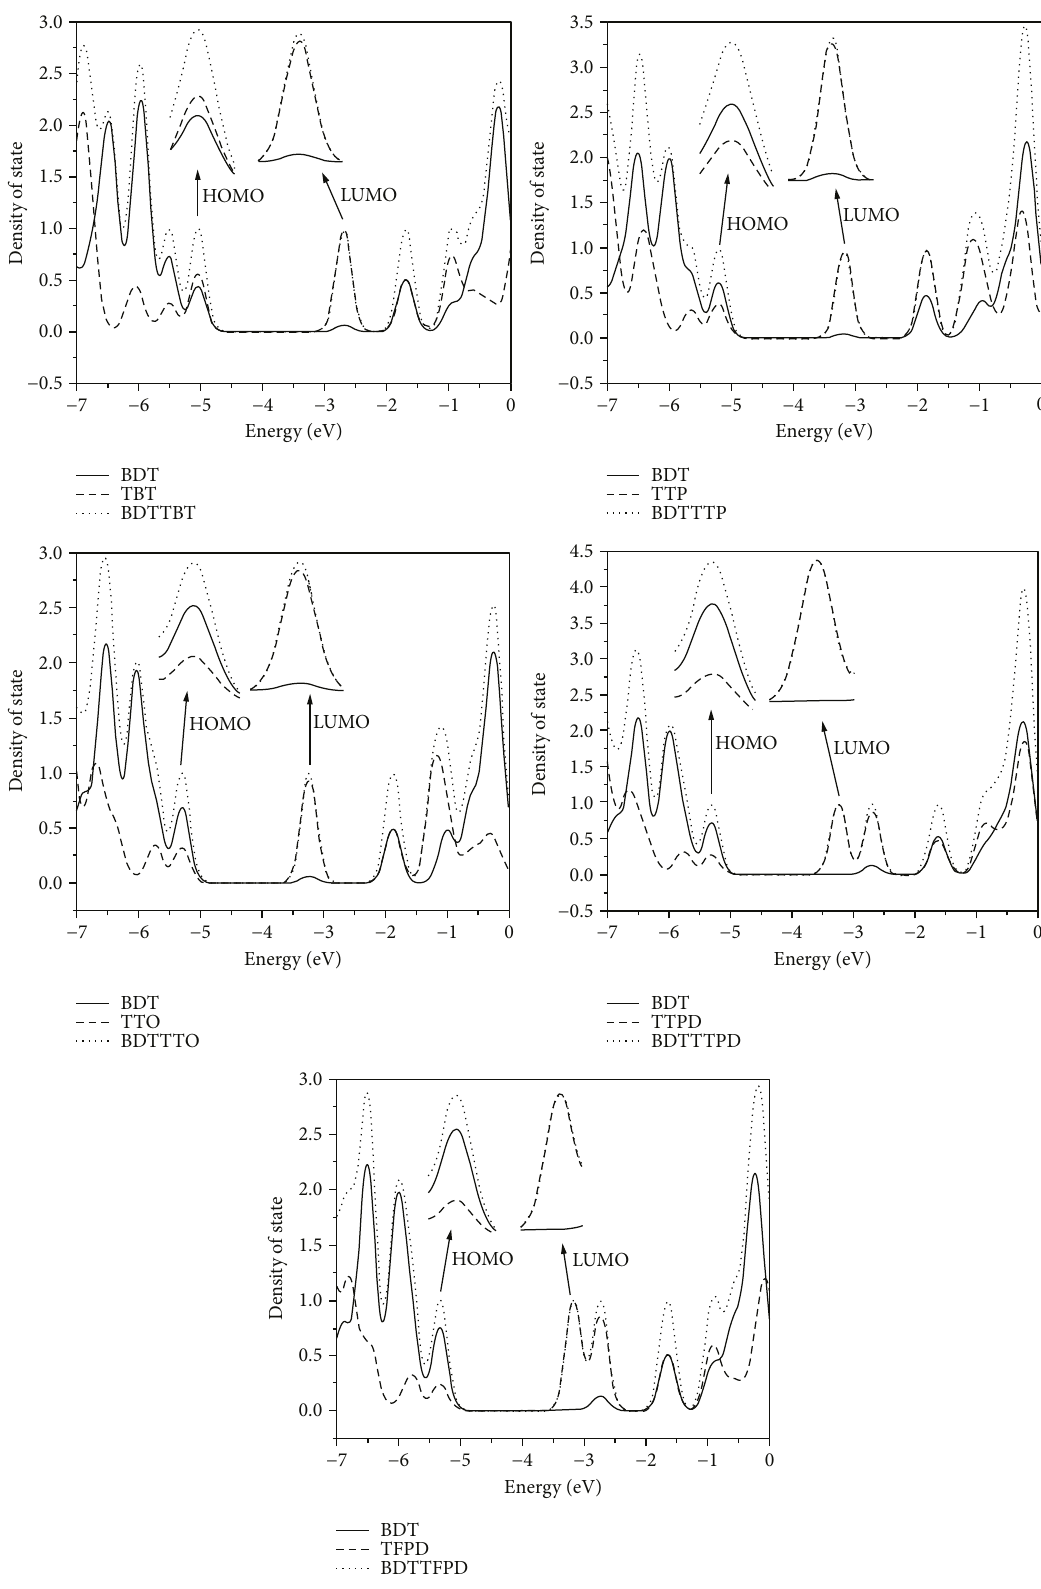
Figure 3: DOS and PDOS of